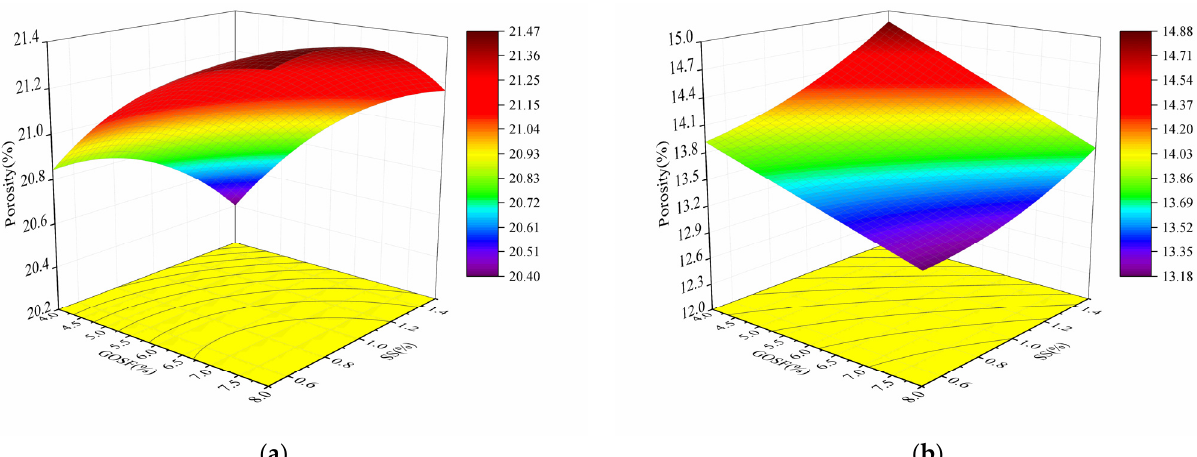
Figure 13. The porosity of samples at 3 days ( a ) and 28 days ( b ) vs. the dosages of GOSF and SS.